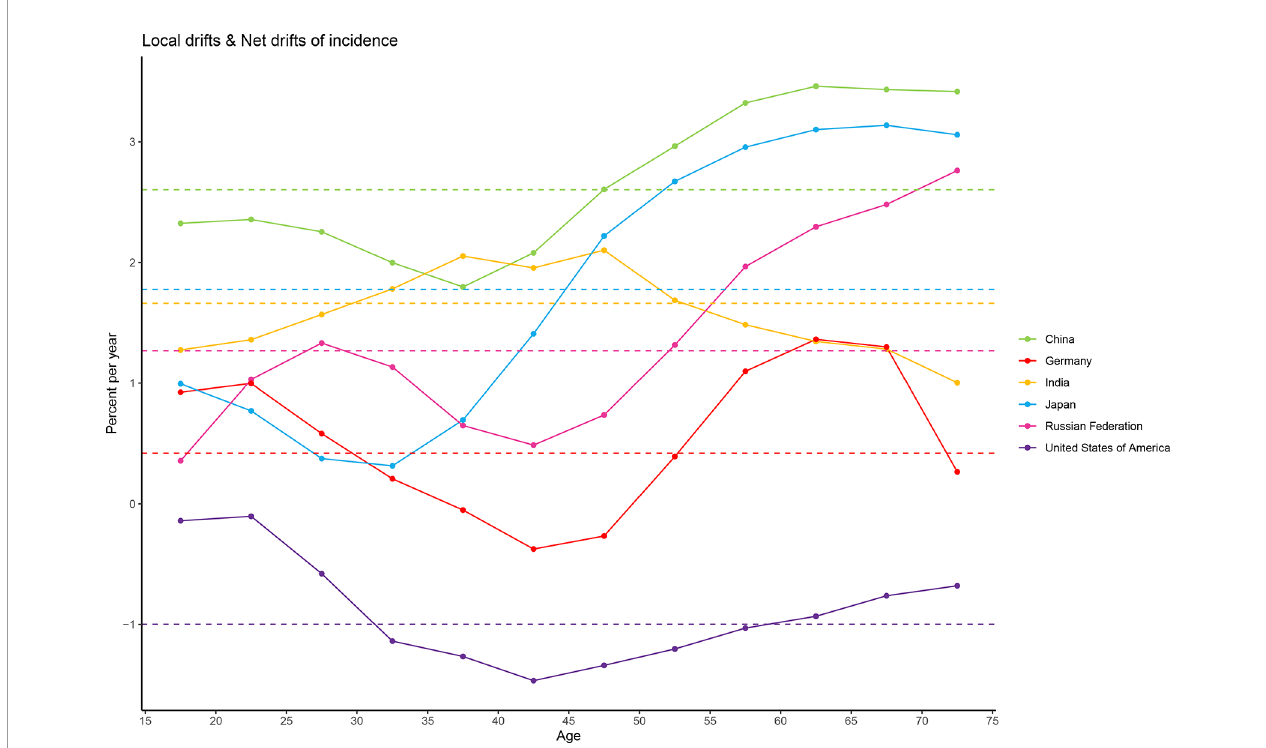
FIGURE 3 | Local drift and net drift values for female breast cancer compared in the six most burdensome countries from 1990 to 2019. Note: Net drift indicates the overall annual percentage change over time, and local drift indicates the annual percentage change of each age group. The horizontal and dashed lines with different colors represent the levels of net drift in different countries, and the broken and solid lines represent the levels of local drift in different